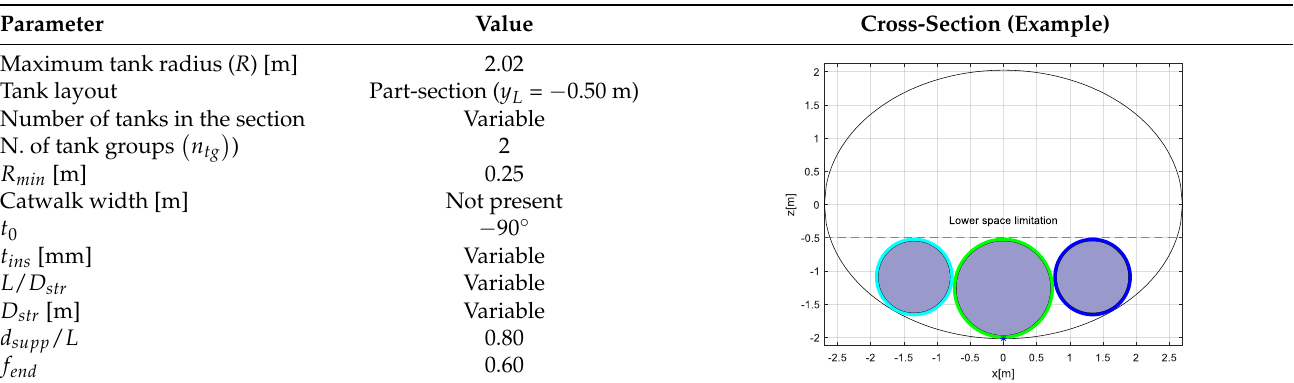
Table 10. Data on the reference multi tank/part-section configuration (cargo deck).